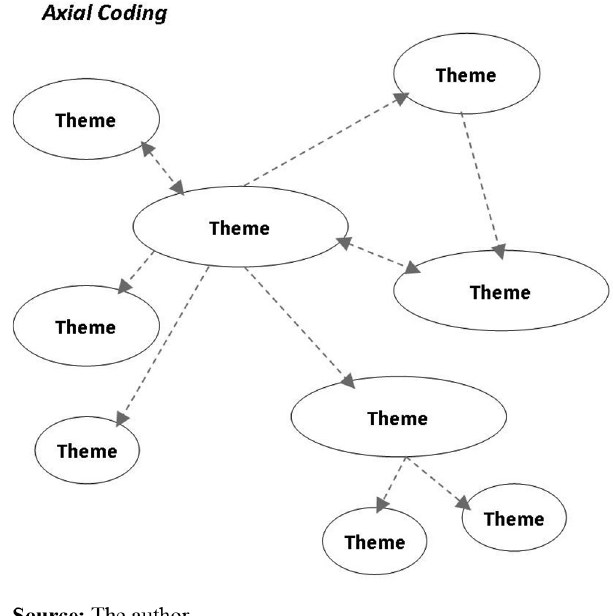
Figure 2. Model of axial